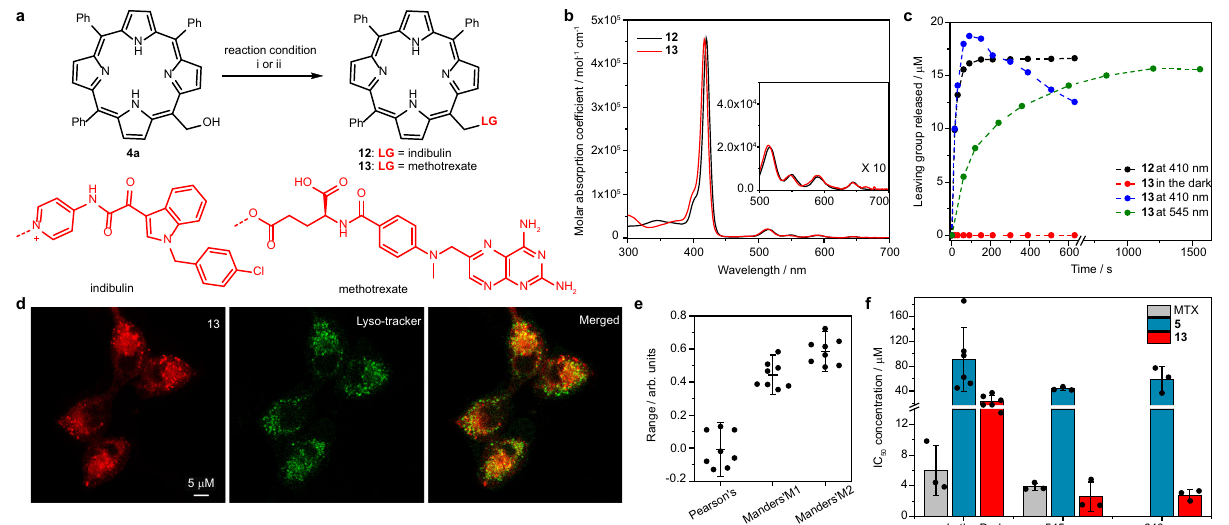
Fig. 3 Meso -methylporphyrin PPG is functional in cellular environment. a Synthesis of meso -methylporphyrin derivatives bearing anti-cancer drugs. i: mesylchloride, indibulin, 20 °C. ii: methotrexate, DMAP, DCC, 20 °C. b Absorption spectra of anti-cancer-caged meso -methylporphyrins (3 µ M, aerated DMSO). Inlet: a 10-fold magni fi cation of the Q-band regions. c Photorelease of leaving groups from meso -methylporphyrin derivatives 12 and 13 (25 µ M, degassed DMSO, λ irr = 410 nm, 40 mWcm − 2 or 545 nm 52 mW cm − 2; HPLC-MS analysis). d Representative fl uorescence microscopy images of the cellular distribution of 13 in cultured murine 4T1 mammary carcinoma cells. Red: compound 13 , green: LysoTracker Green. e Co-localization parameters of 13 and LysoTracker Green. The middle line represents the mean, and error bars represent the standard deviation. f Calculated IC 50 concentrations of 5 and 13 in cultured murine 4T1 mammary carcinoma cells following or not irradiation with 545 nm (5 min) or 640 nm (10 min) light. The experiment was repeated at least three times in triplicates; error bars represent the standard deviation.